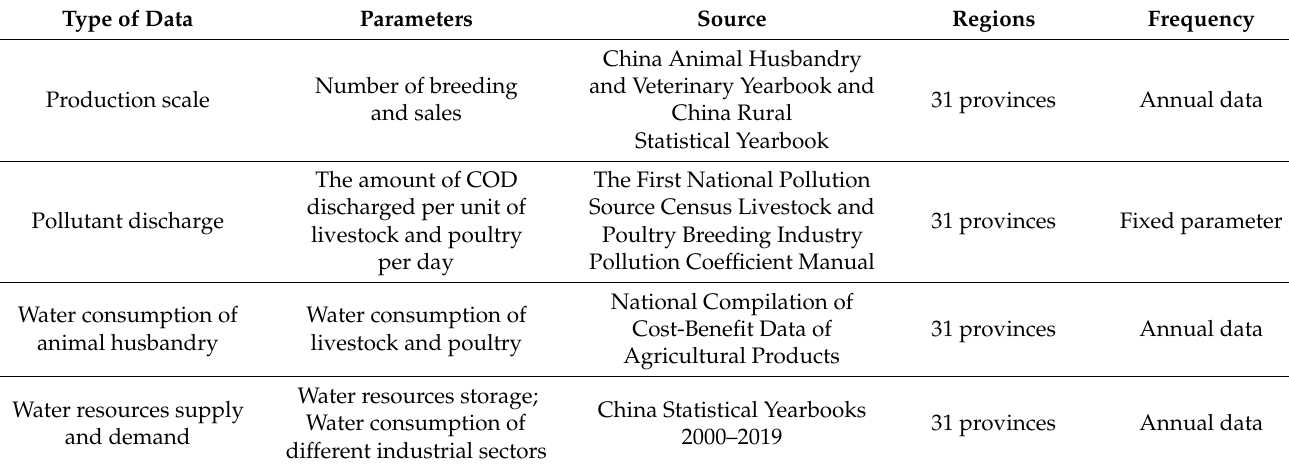
Table 2. Summary for the sources of all the original data used in current